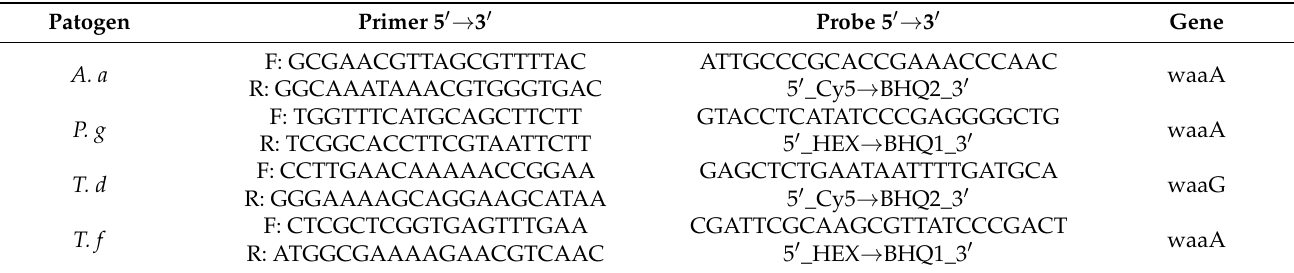
Table 1. Sequence of primers and probes.